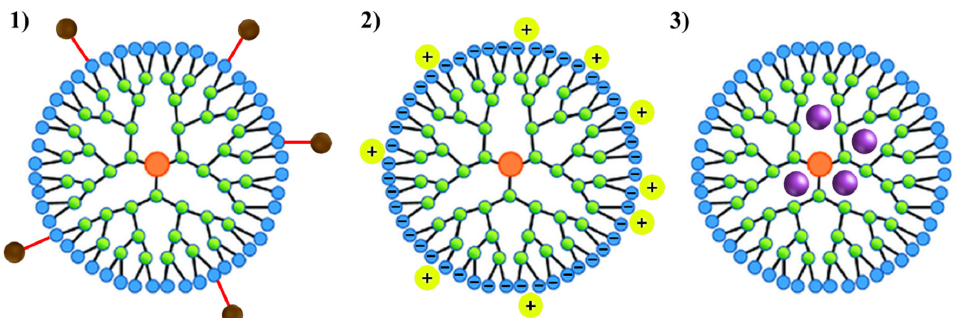
Figure 5. Schematic representation of the 3 mechanisms used to load drugs in dendrimers: ( 1 ) through a covalent interaction between the drug to the periphery of the dendrimer; ( 2 ) by coordination of the drug to the outer functional groups of the dendrimer via ionic interactions; ( 3 ) by simple encapsulation of the drugs into the dendrimer cavities.